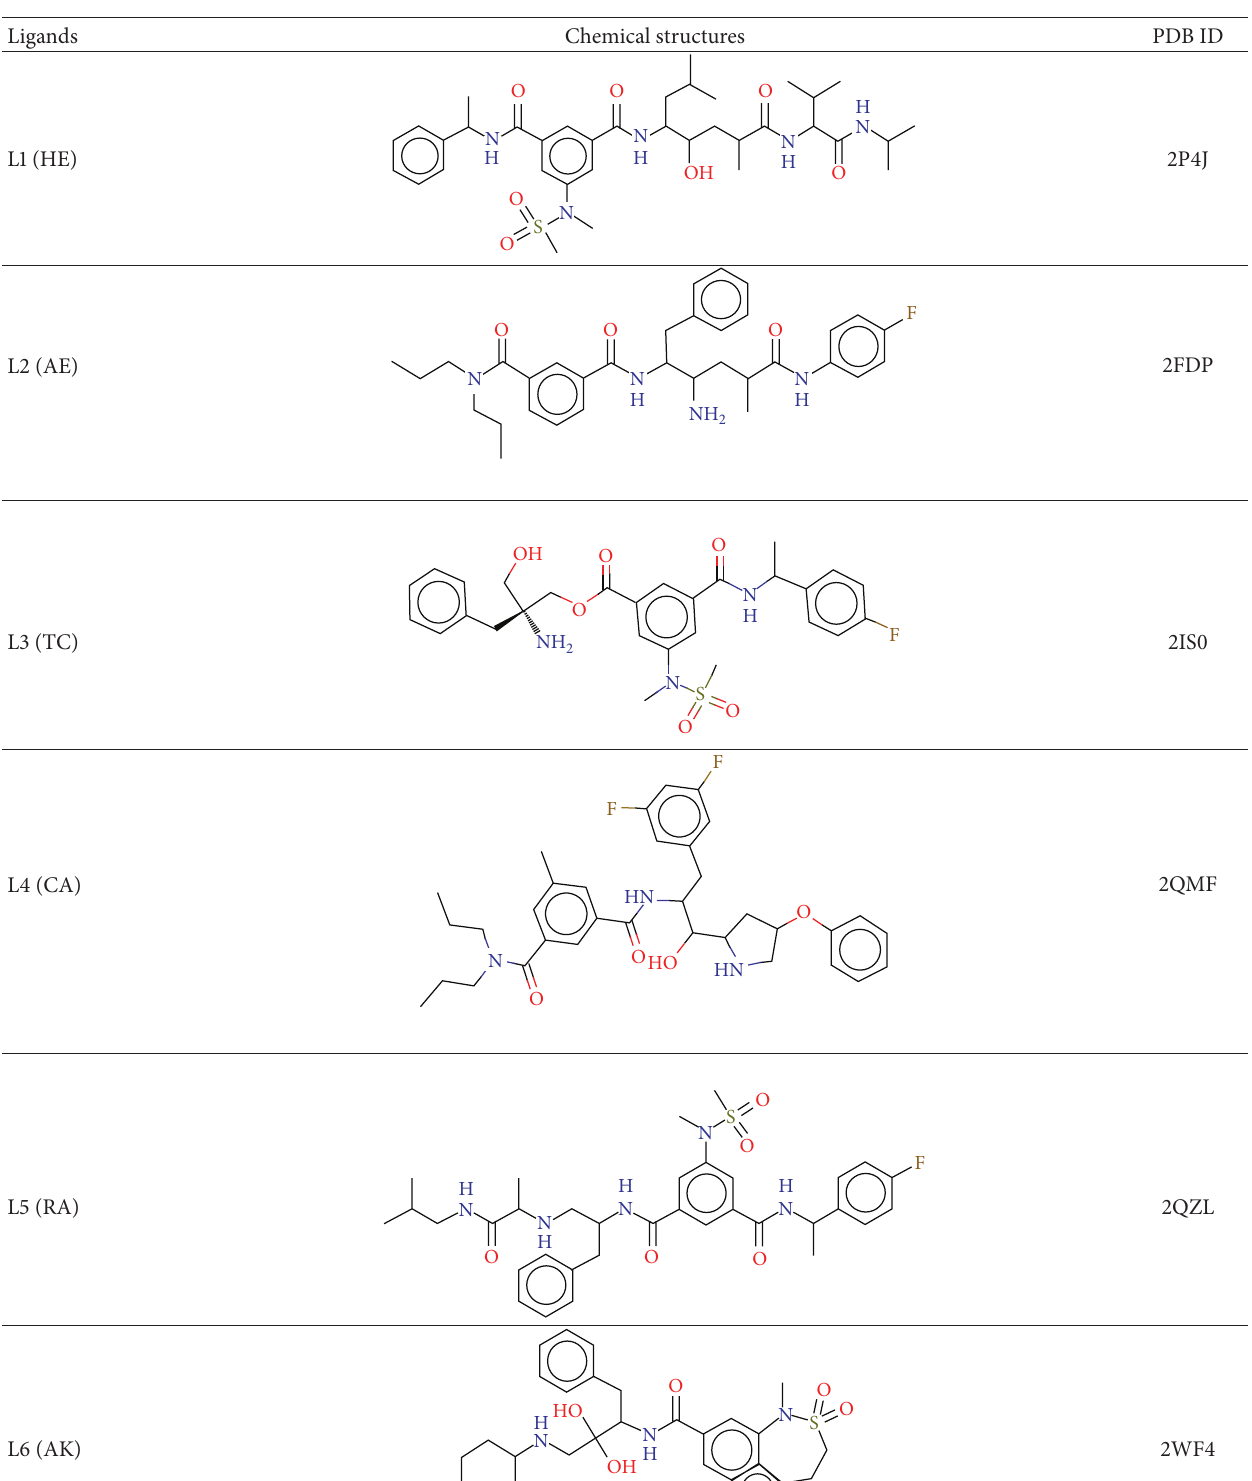
Table 1: Ligands with chemical structure and PDB ID of cocrystal structure of BACE1.